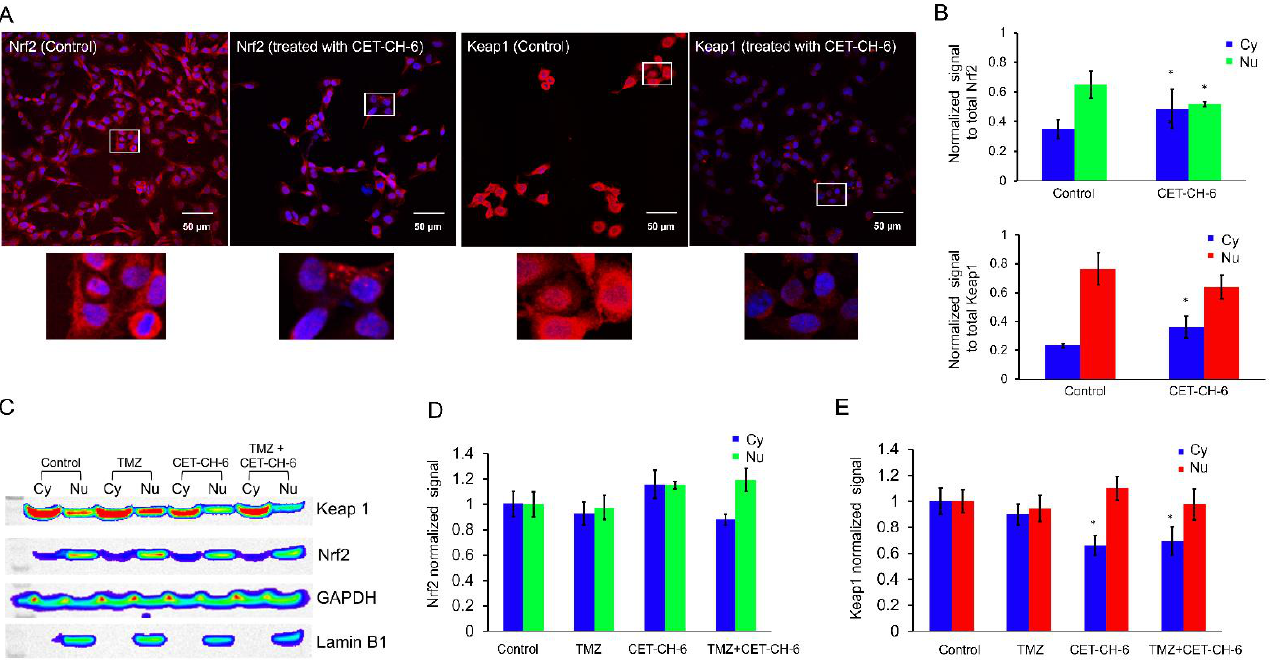
Figure 3. Mechanism of inhibition of Nrf2 in response to treatment with CET-CH-6 in combination with TMZ. ( A ) Confocal microscopy of MDA-MB-231 cells treated with CET-CH-6 and stained with Nrf2 and Keap1 (zoom = 10 × ). Zoomed in images of the white boxes are shown below each image; ( B ) quantitative analyses of immunofluorescence images shown in ( A ), signals are normalized to the total amount of proteins expressed; ( C ) Western blotting images of MDA-MB-231 cells treated with CET-CH-6, TMZ or their combination for 24 h with quantitative plot of ( D ) Keap1 and ( E ) Nrf2. Protein expressions measured in cytoplasm (Cy) and nucleus (Nu) are normalized to GAPDH and Lamin B1, respectively. All the Western blot images are shown in Figure S2 in the Supplementary Material. In ( D , E ) the plots are normalized to control Cy and control Nu, respectively. Error bars represent mean ± SD. * represent p -value < 0.05.